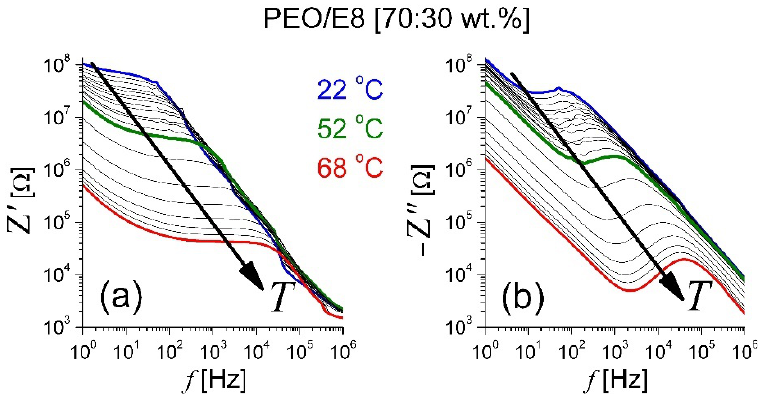
Figure 1. Frequency spectra of complex electrical impedance of PEO/E8 composite film: ( a ) real part ( Z′ ) and ( b ) imaginary part ( Z ″ ). Spectra were recorded under identical experimental conditions, by varying the temperature of the film in the range of 22 °C to 68 °C. The arrows show the effect of increasing temperature.